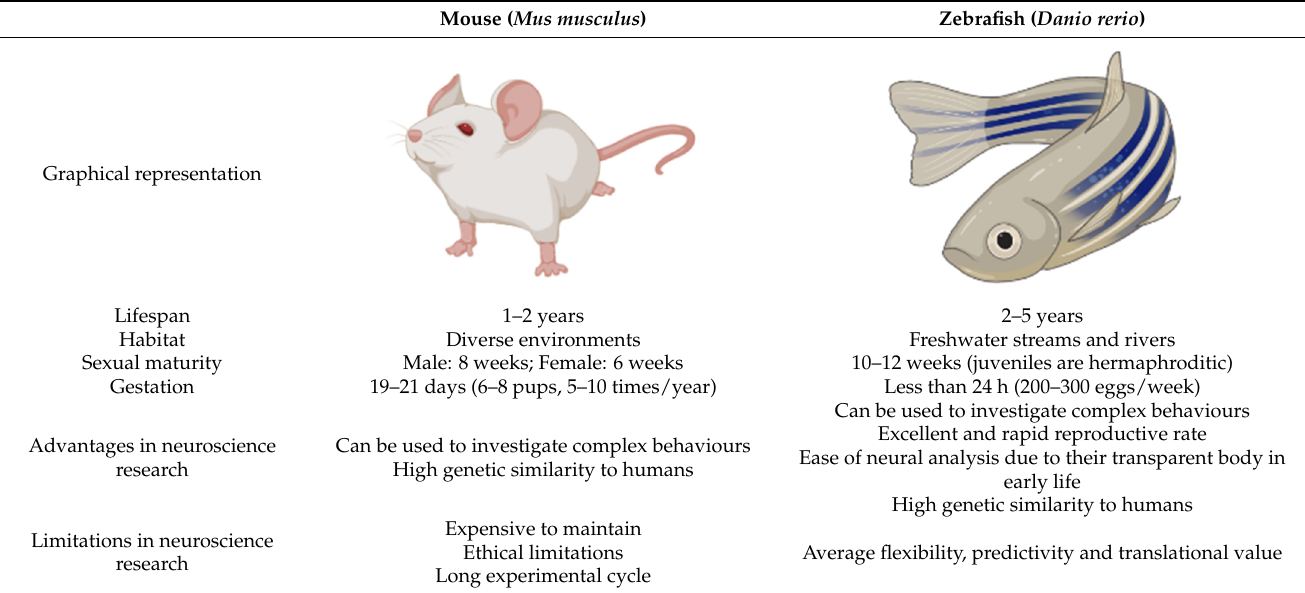
Table 4. Comparison of mouse and zebrafish as animal models in neuroscience. This table shows specific differences between mice (mammalian) and zebrafish (teleost).